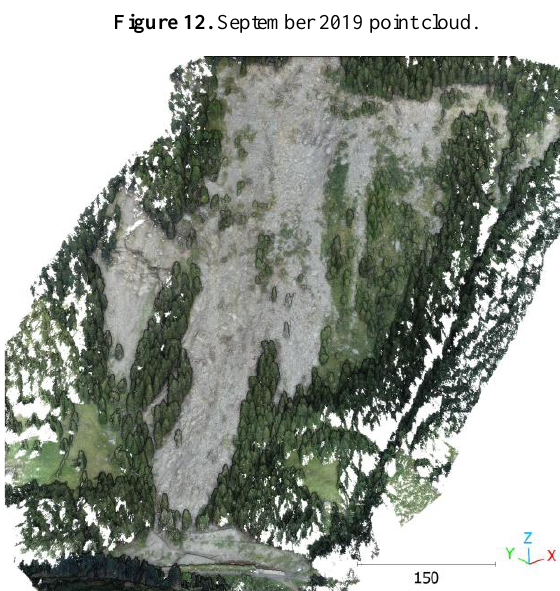
Figure 13. September 2020 point cloud.